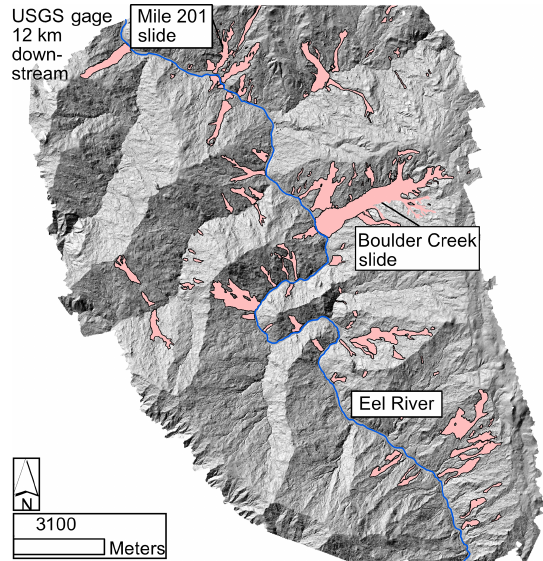
Figure 4. Shaded relief map of the Eel River site. The thalweg of the Eel River is shown in blue. Areas of red shading are active earth- flows mapped by Mackey and Roering (2011). River flow is from the lower right to upper